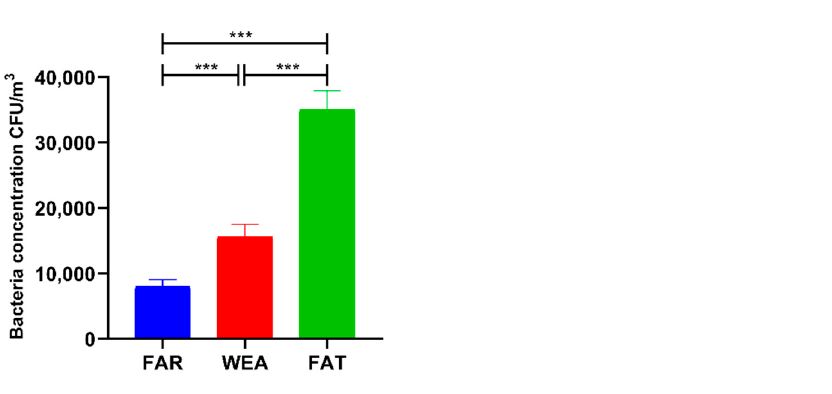
Figure 1. Concentrations of culturable airborne bacteria in different types of pig houses using an Andersen sampler (data presented as means ± SD. *** p < 0.001). FAR, farrowing houses; WEA, weaning houses; FAT, fattening houses.